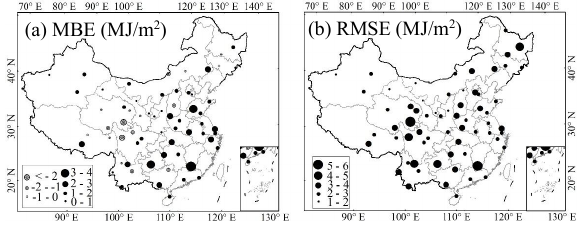
Figure 5 . Distributions of the error statistics of the daily global SSI estimated from March 2016 to March 2017.